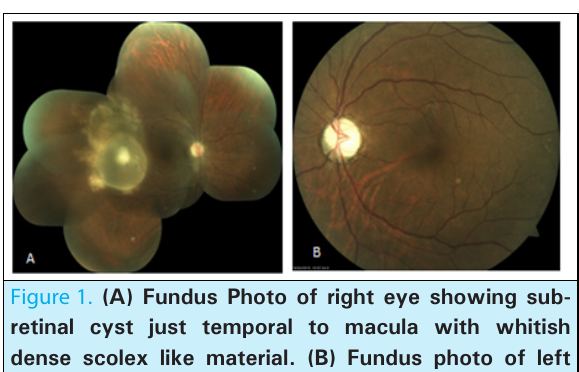
Figure 1. (A) Fundus Photo of right eye showing sub- retinal cyst just temporal to macula with whitish dense scolex like material. (B) Fundus photo of left eye showing pale disc with dull foveal reflex.